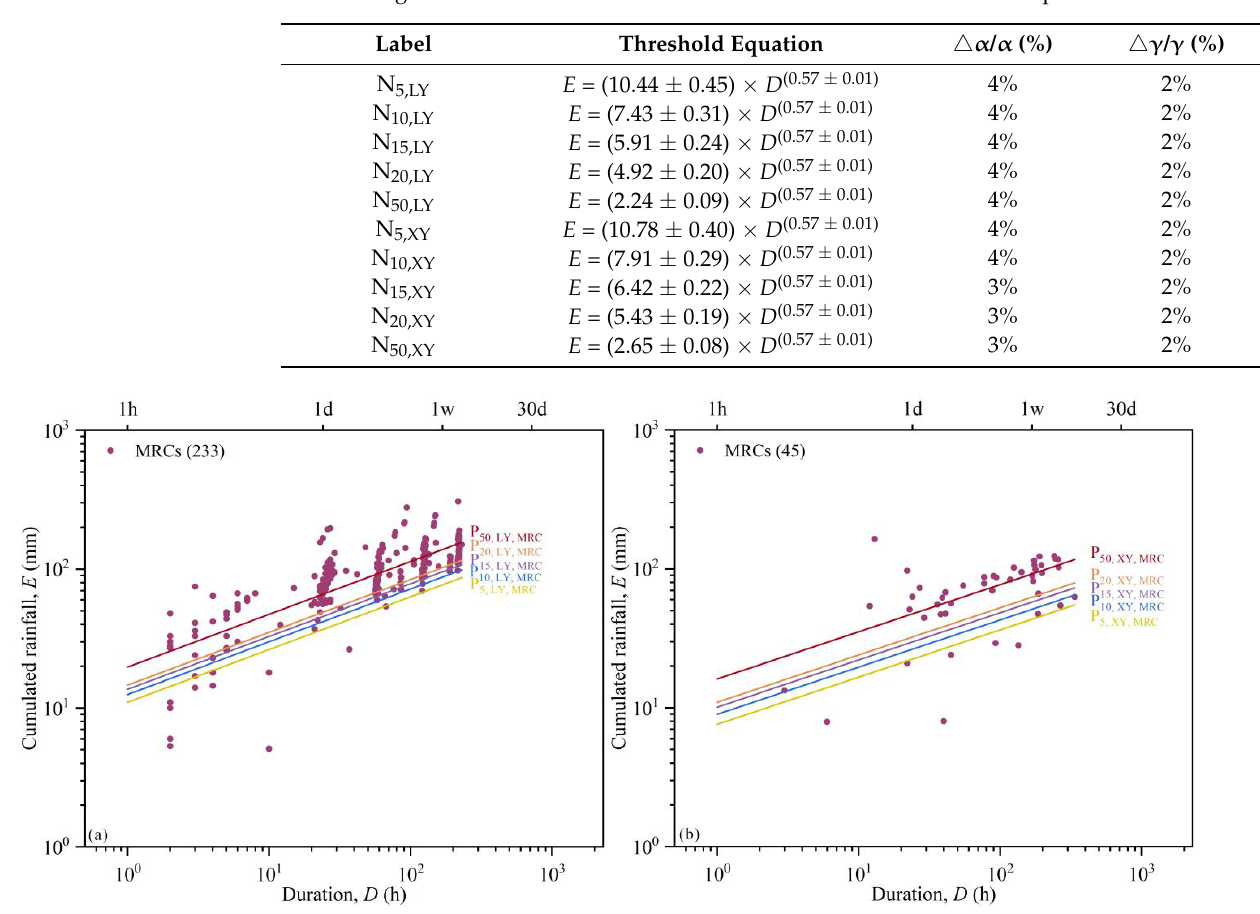
Figure 7. Defined positive rainfall thresholds based on MPRC: ( a ) LY county; ( b ) XY county. Table 5. Positive threshold functions and relative uncertainties of threshold parameters. Label